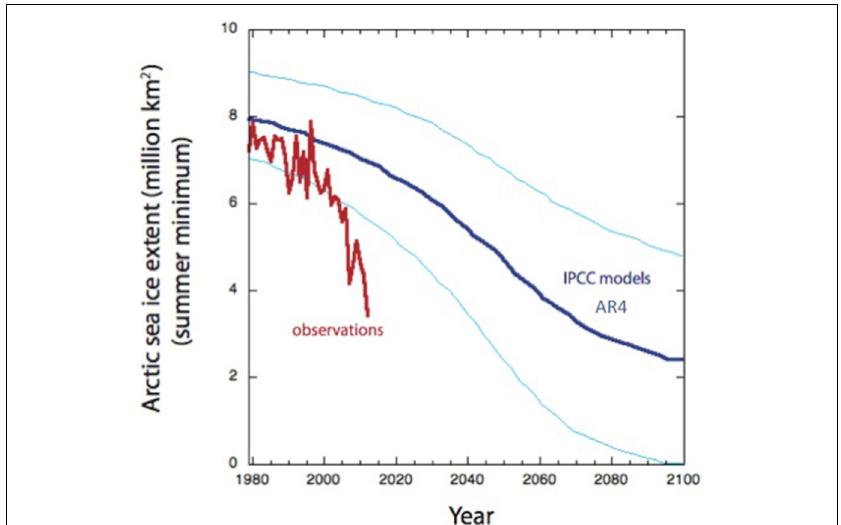
FIGURE 5 | The predicted (thick blue line mean and thin blue lines uncertainty bands, based on AR4 IPCC models, Meehl et al., 2007) and observed (red line) annual minimum sea ice extent (1979–2012). Observed ice extent from Fetterer et al. (2014) (2002, updated 2009, Accessed August 5,